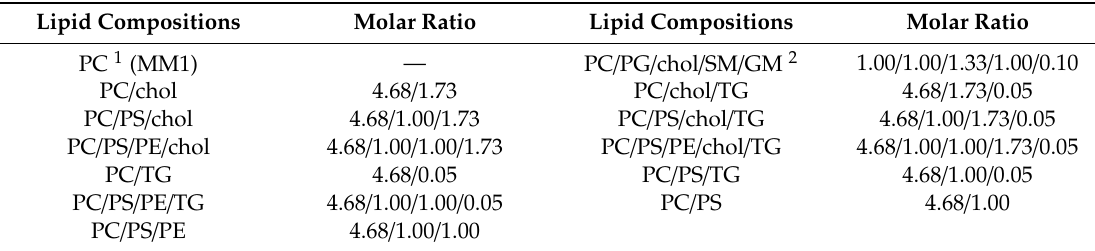
Table 1. List of model bilayers used in the present